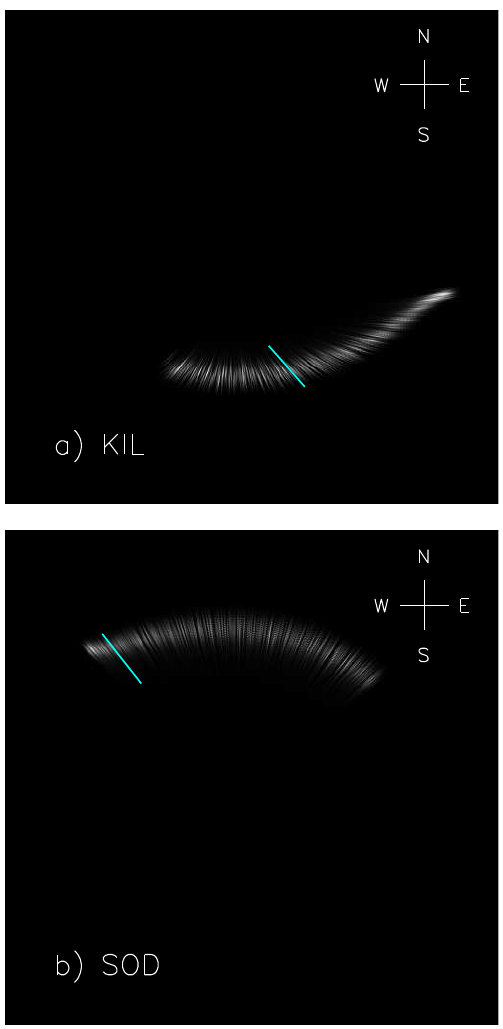
Fig. 2. Synthetic images of the same arc for all-sky cameras in (a) Kilpisj¨arvi and (b) Sodankyl¨a. A single geomagnetic field line is highlighted in cyan. 25